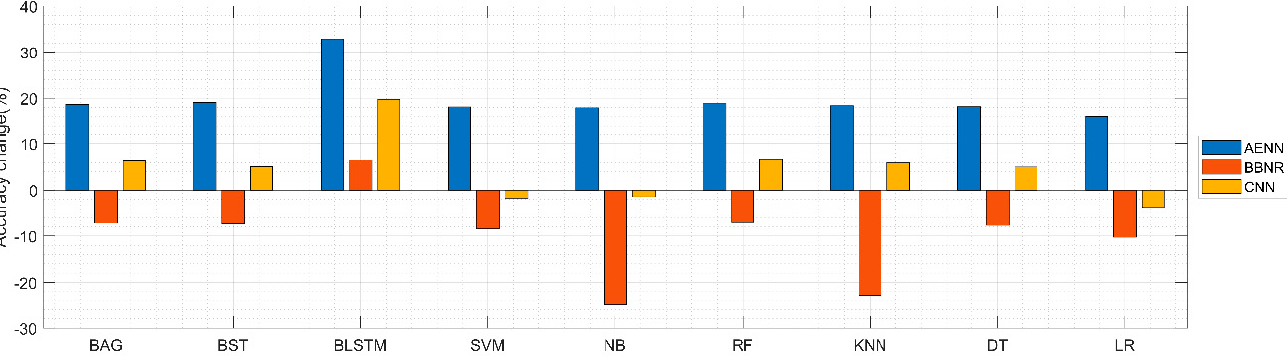
Figure 2. Performance change of filtering methods (AENN, BBNR, and CNN) as compared to baseline (no filtering used) results.